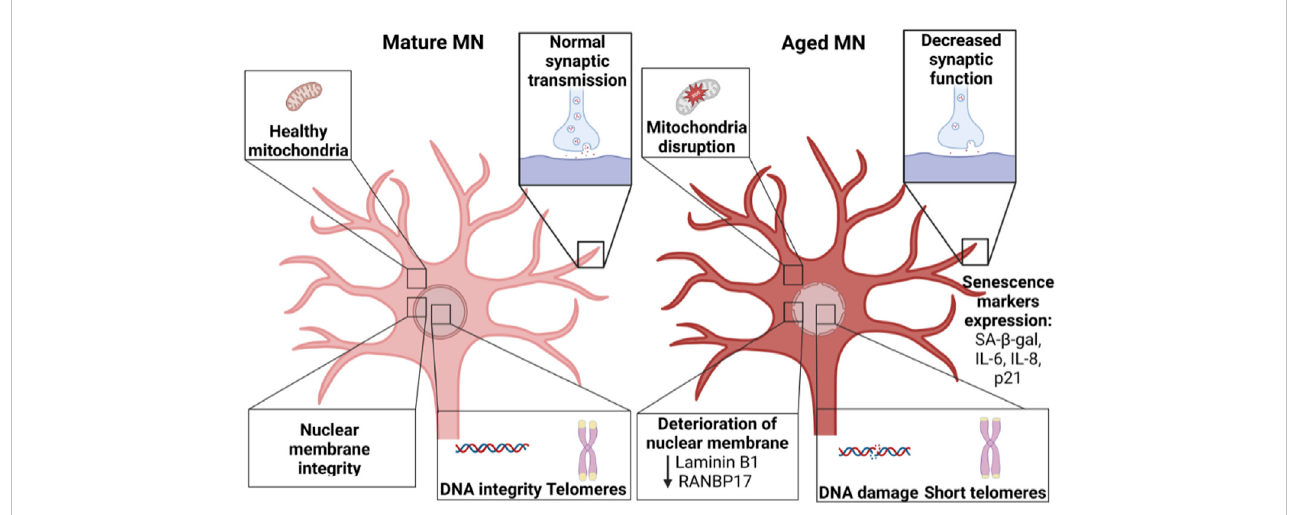
FIGURE 3 Comparison between mature MNs and aged MNs. “ Aged ” MNs show considerable differences compared to “ young ” MNs, including changes in mitochondria, synaptic function, integrity in the nuclear membrane integrity as well as increased DNA damage and reduced telomere length. Created with